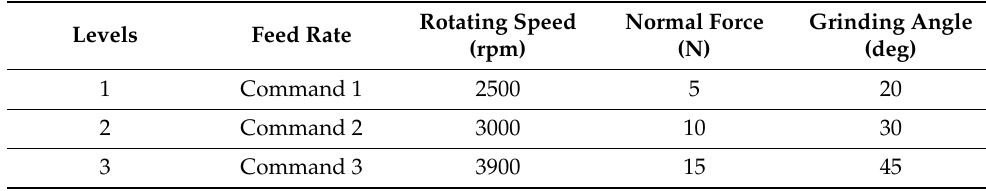
Table 1. Set levels of the grinding parameters.